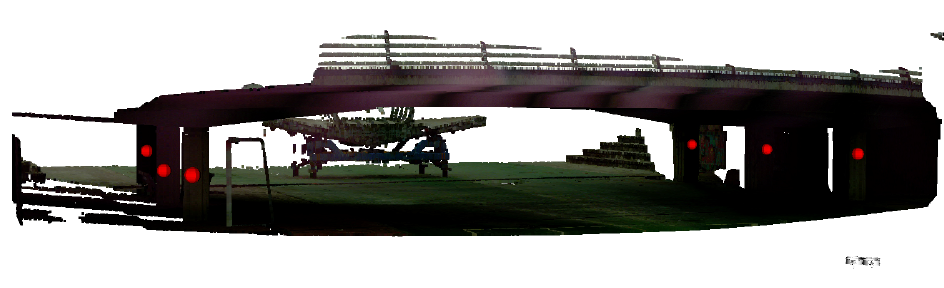
Figure 7. Scan of bridge and landmarks to determine consistency in the experiments.